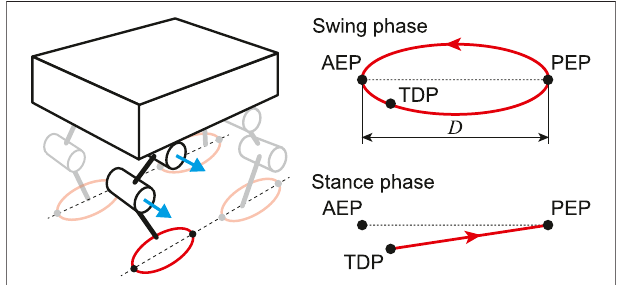
FIGURE 3 | Desired leg kinematics composed of swing and stance phases. At touchdown position (TDP), trajectory changes from swing to stance phase. When leg tip reaches posterior extreme position (PEP), trajectory moves into swing phase. Anterior extreme position (AEP) is desired position of